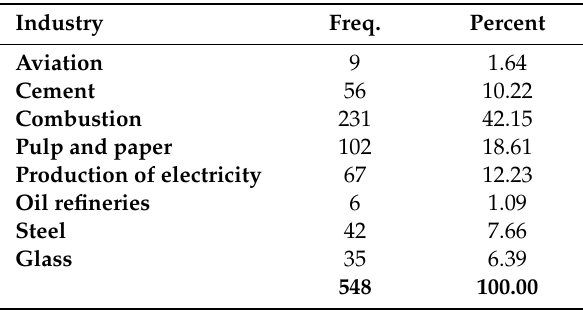
Table 4. Frequencies for